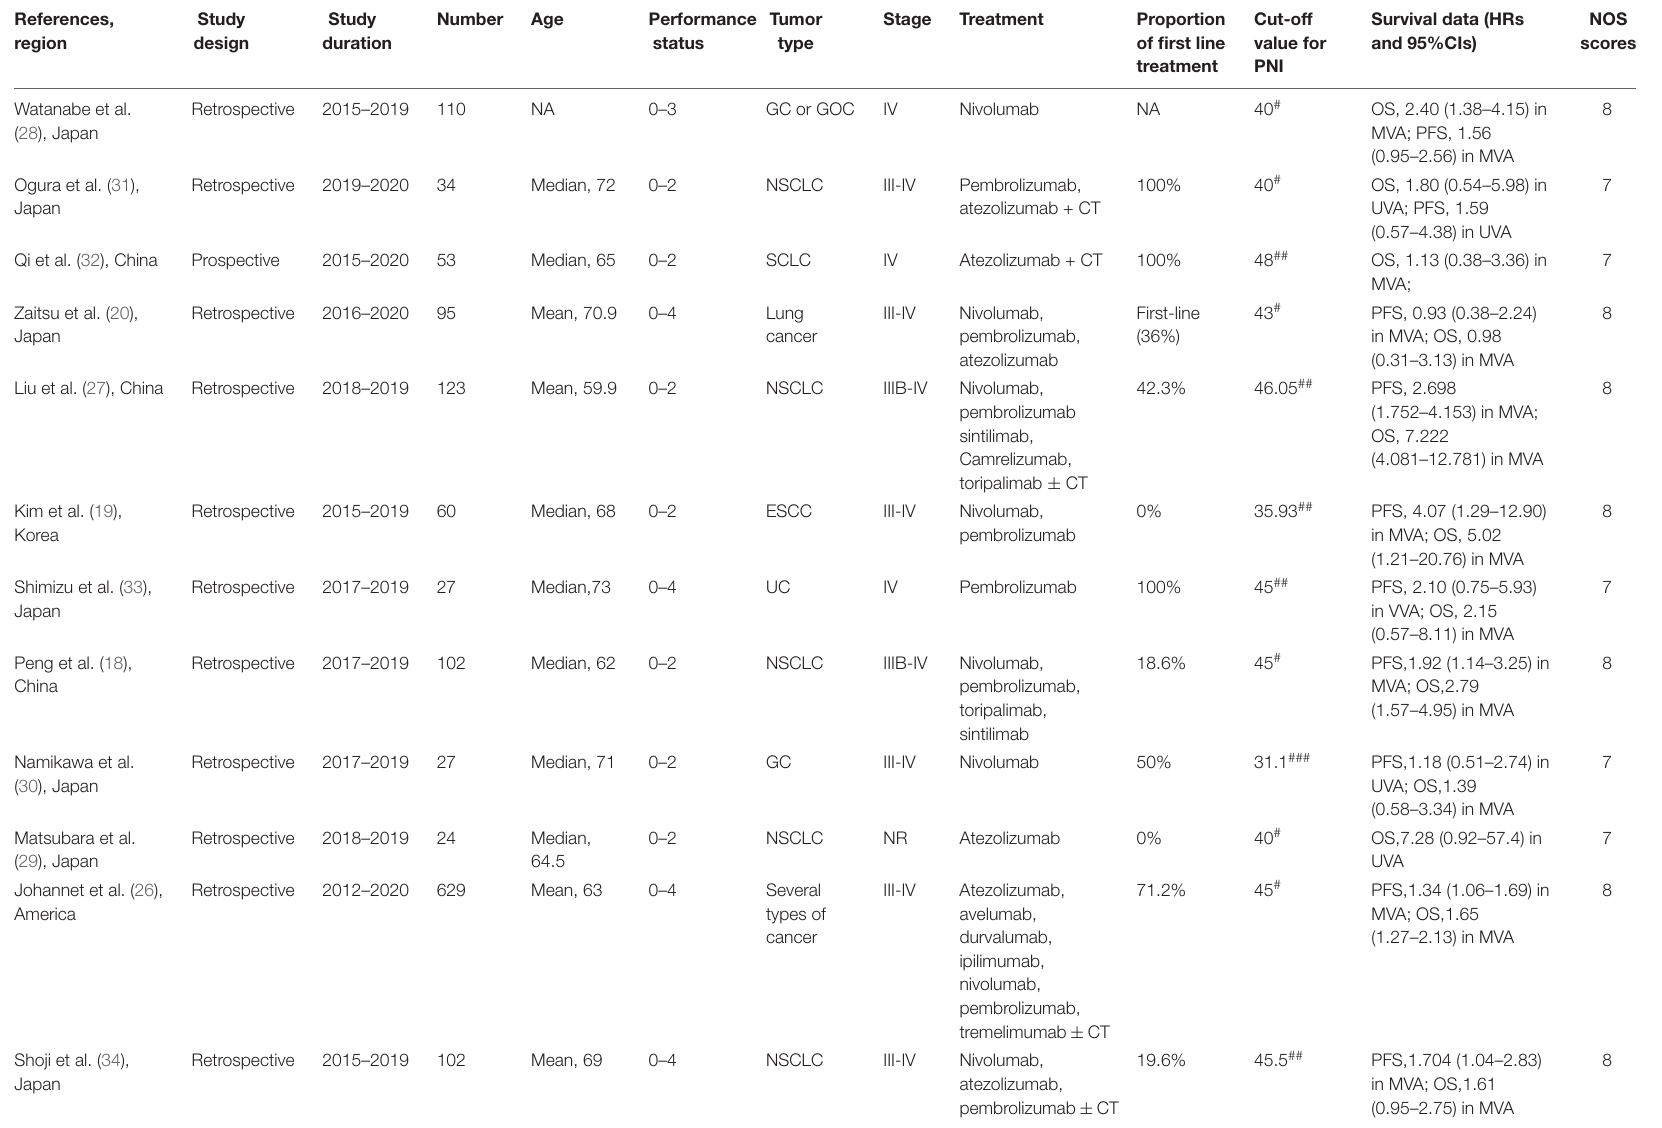
TABLE 1 | Characteristics of included studies for